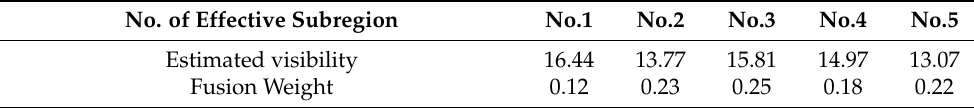
Table 4. The estimated results of different effective area.